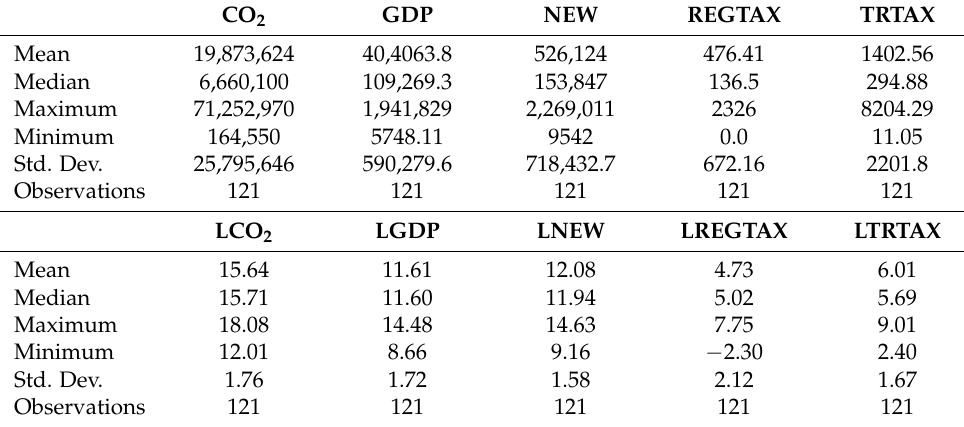
Table 2. Descriptive statistics